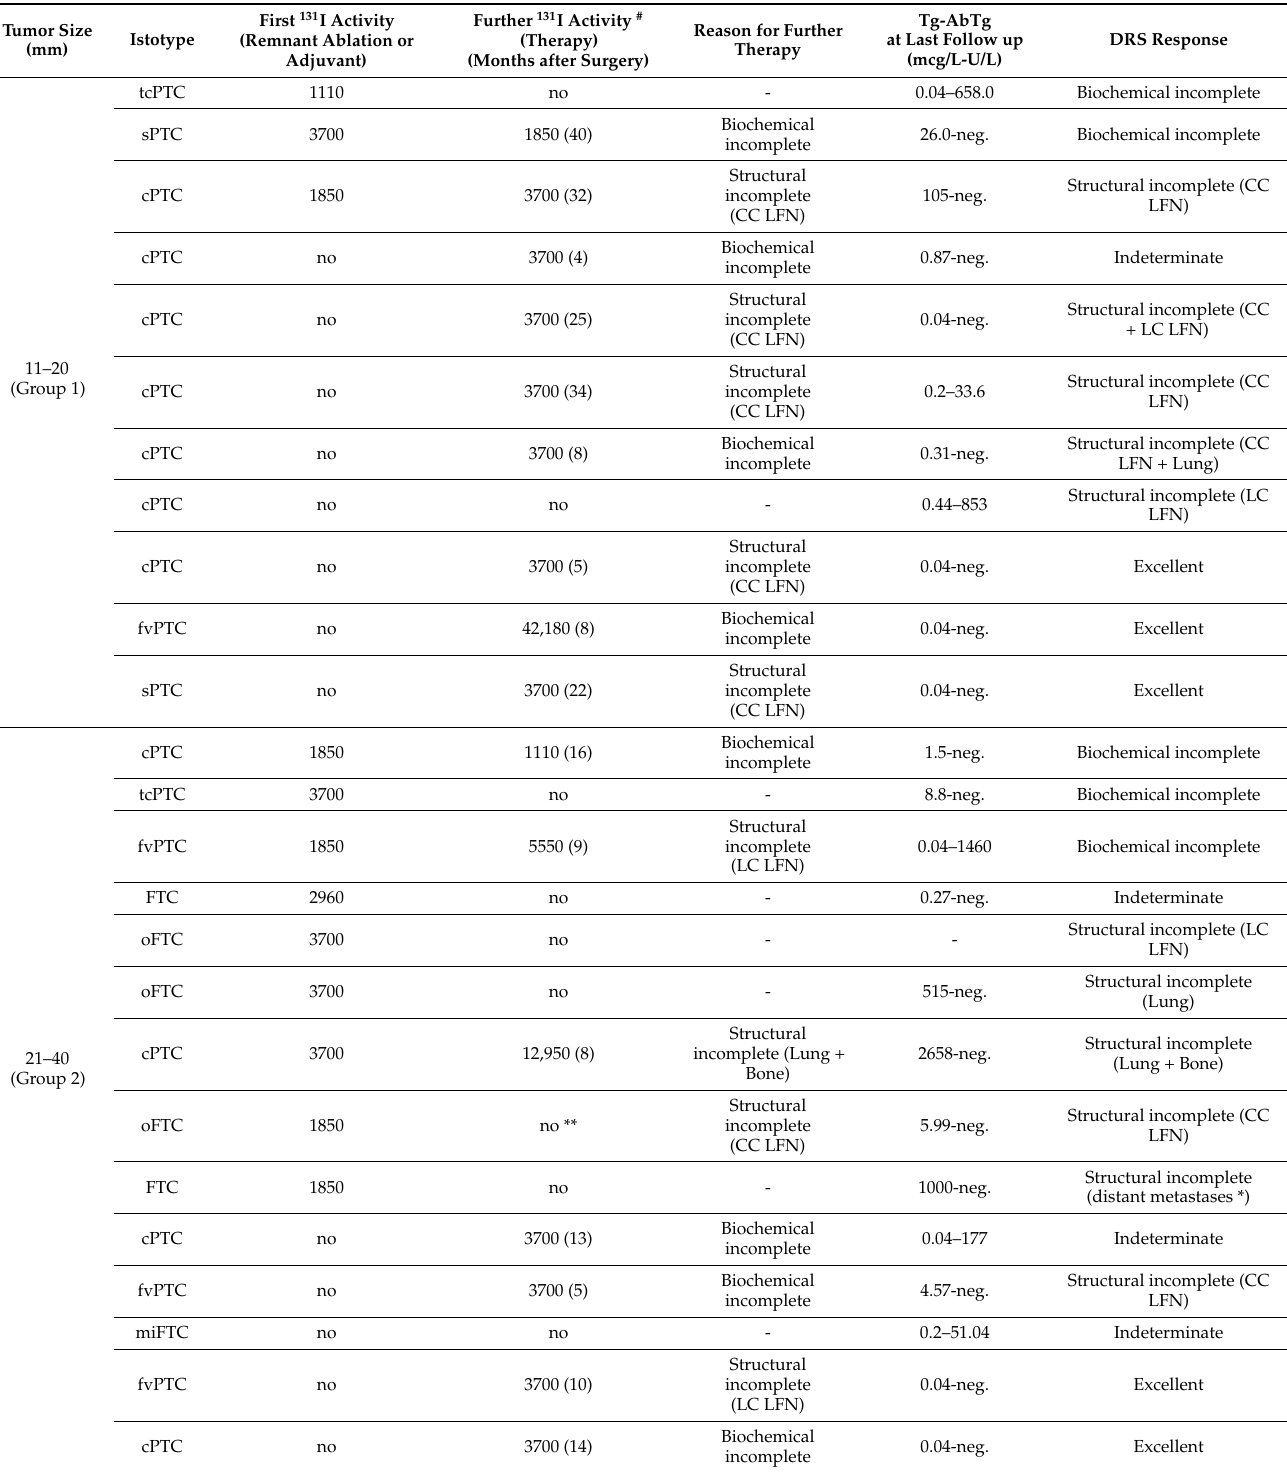
Table 2. Clinical data and follow up of patients (Group 1 and Group 2) with persistent disease after surgery alone or after surgery and ablative/adjuvant 131 I